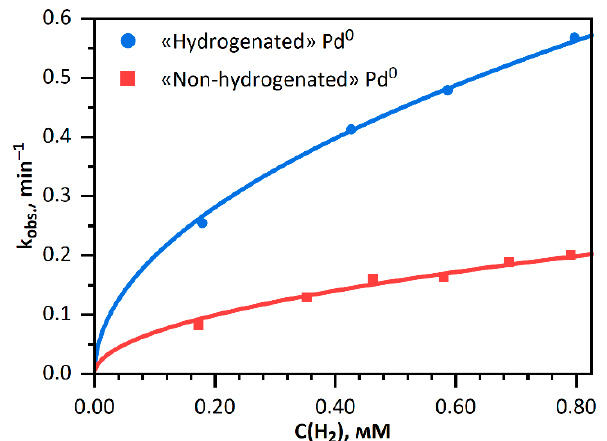
Figure 6. Observed rate constant of Fe(CN) 63 – reduction with hydrogen in the presence of «hydrogenated» palladium «non-hydrogenated» palladium vs. hydrogen concentration in the solution. The dots correspond to the experiment and the curve shows calculations. Solution: [ Fe(CN) 63 – ] = 1.00 mM; [ Pd 0 ] = 0.020 mM.